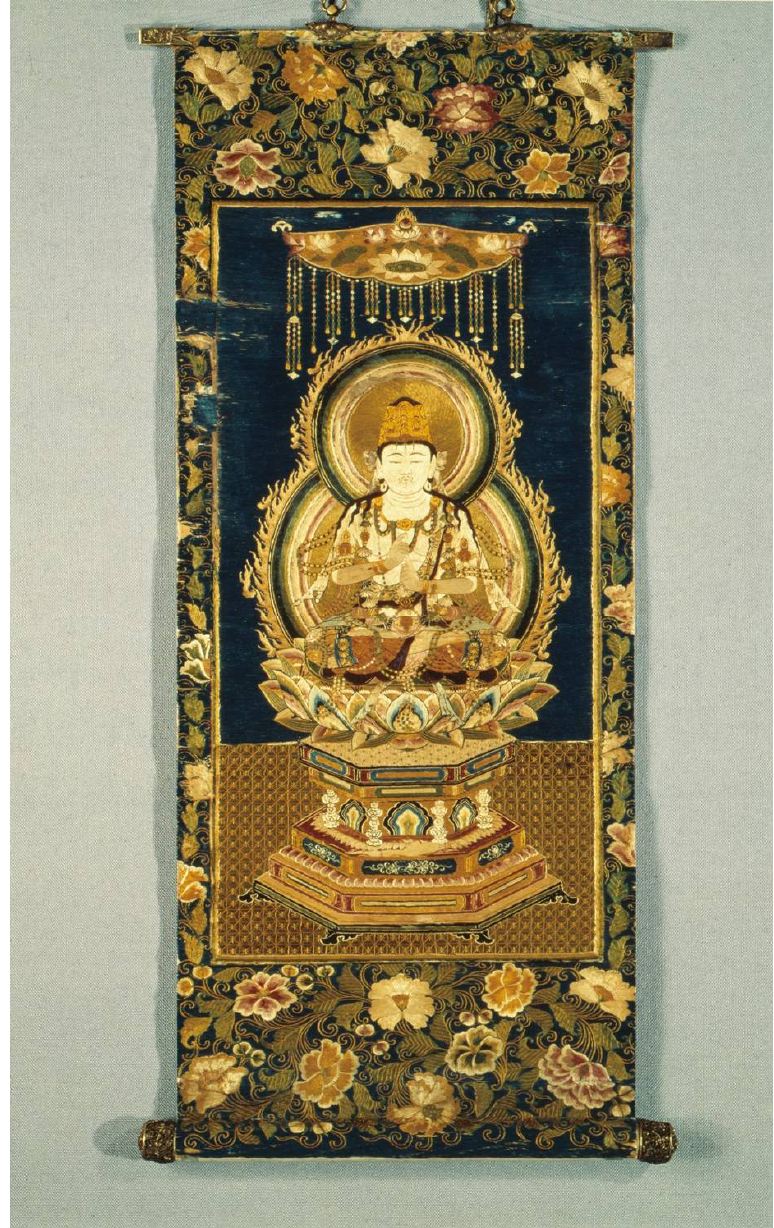
Figure 5. Dainichi nyorai, Kamakura Period (13th–14th century), Hair and silk thread embroidery on plain weave silk, Hosomi Museum, Kyoto Prefecture, Height: 41.2 cm, Width: 25 cm. Source: Hosomi